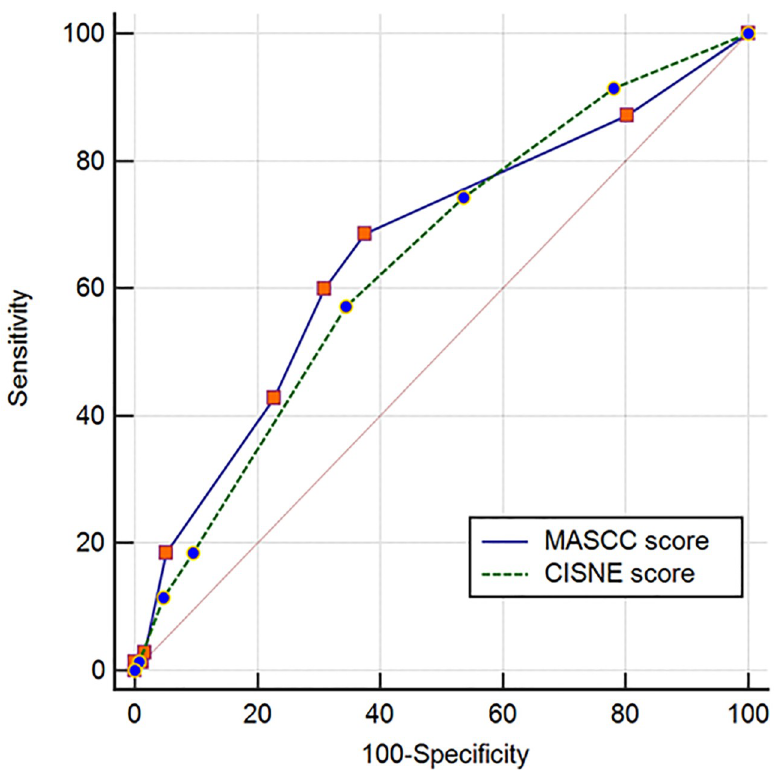
Fig 3. Receiver operating characteristic (ROC) analysis with respect to the MASCC score and CISNE score. Each variable’s AUC was 0.66 (95% CI; 0.60–0.71) and 0.64 (95% CI; 0.59–0.70), respectively. The difference between areas was 0.02 (95% CI;-0.08–0.11) and not statistically significant (P =